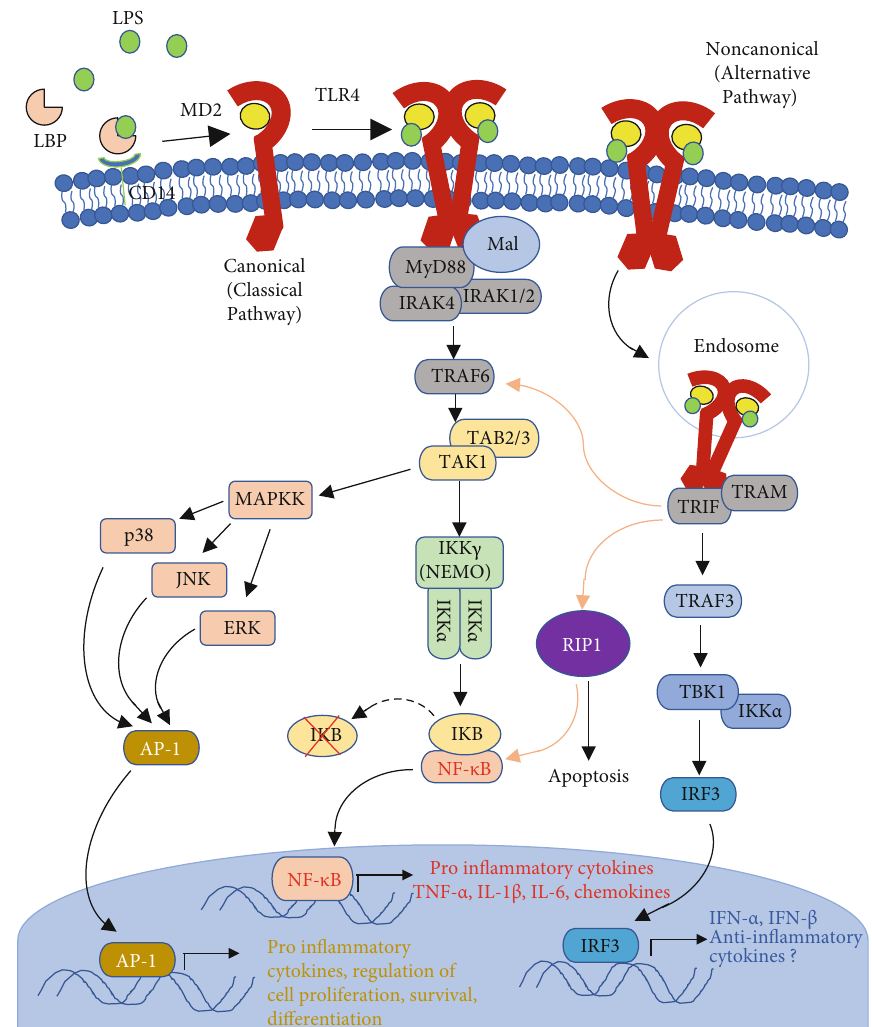
Figure 2: Overview of the main TLR4 signalling pathways. TLR4 can be activated by LPS (classical PAMP), DAMPs, or viral PAMPs. LPS is also picked up by the LPS-binding protein (LBP) present in the blood and in extracellular fl uid in tissues. LPS is transferred from LBP to the coreceptor CD14. Recognition by MD2 and TLR4 binding results in the nuclear induction of transcription factors NF- κ B and AP-1 via the MyD88-dependent pathway involving IRAKs, TABs, TAK, MAP kinases, and IKK isoforms. This results in the transcription of proin fl ammatory cytokines and regulators of cell proliferation, survival, and di ff erentiation. In fi broblasts, this pathway mediates myo fi broblast di ff erentiation and results in CTGF and collagen production [100], while the alternative pathway is endosomal and involves TRIF and TRAM complex formation at the TIR domain. The alternative pathway results in the expression of anti-in fl ammatory cytokines, interferons α and β regulated by interferon regulatory factor 3 (IRF3), in addition to some NF- κ B nuclear translocation. “ Cross-talk ” activation between the two pathways is indicated by brown arrows. Adaptors and cascade proteins are usually in homodimers, like the TLR4 receptor [22], but were omitted here for